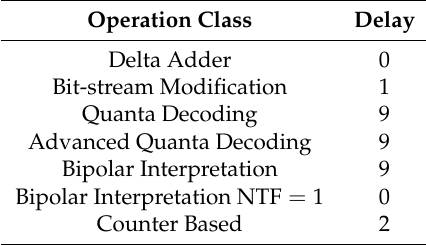
Table 4. Phase delay in clock cycles of linear operation classes.